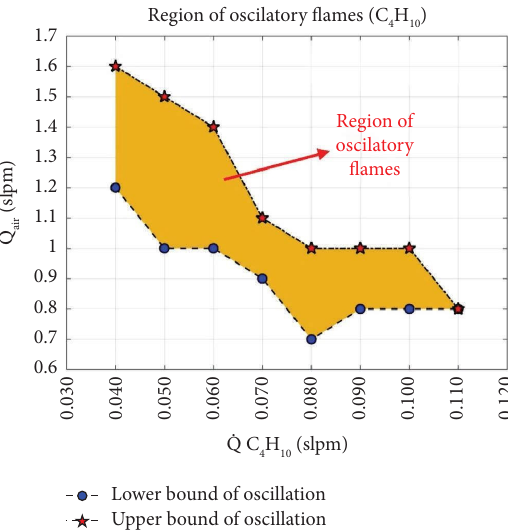
Figure 5: Region of oscillatory fames.